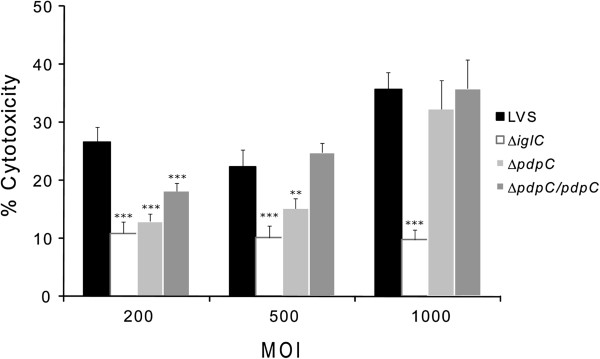
LDH release from F.tularensis-infected cells. Culture supernatants of infected J774 cells were assayed for LDH activity at 24 h with a MOI of 200, 500, or 1,000. The activity was expressed as a percentage of the level of uninfected lysed cells. The value of uninfected cells at 24 h was 14.6 ± 1.6%. Means and SEM of six replicate wells are shown. The asterisks indicate that the LDH levels were significantly different to those of LVS-infected cells at the same time point as determined by a two-sided t-test with equal variance (**: P < 0.01, ***: P < 0.001).